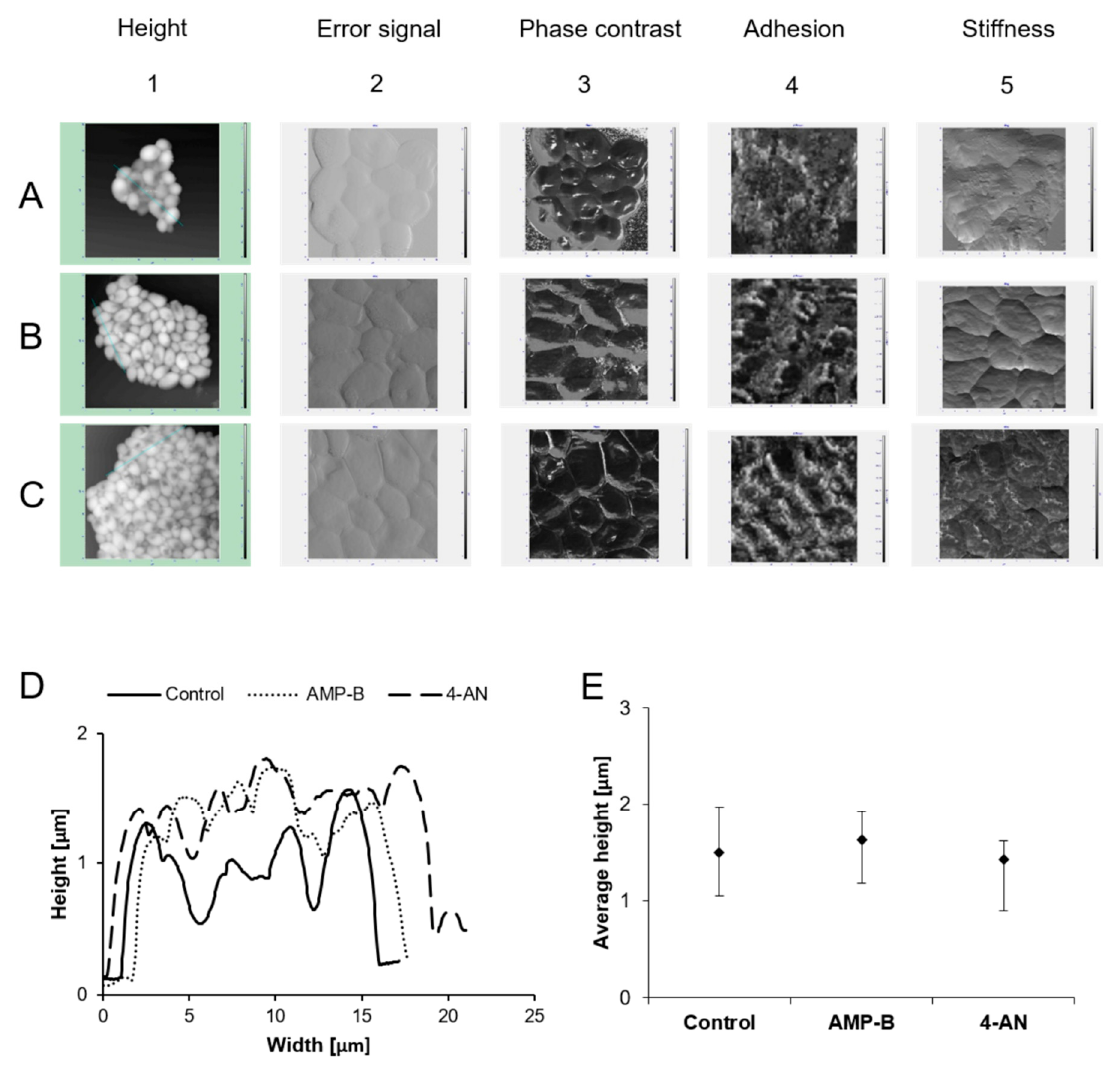
Figure 3. Multiparametric imaging of Candida albicans cells by AFM: ( A ) Control cells, ( B ) positive control (AMP-B), and ( C ) cells treated with 4-AN. Cross-sections of images A1, B1, and C1 were traced to determine the height of the cells. Pictorial parameters: height (1), error signal (2), phase contrast (3), adhesion (4), stiffness (5). ( D ) The difference in height between the cells represented by the height profile. ( E ) The height of C. albicans cells—standard deviations (SD).